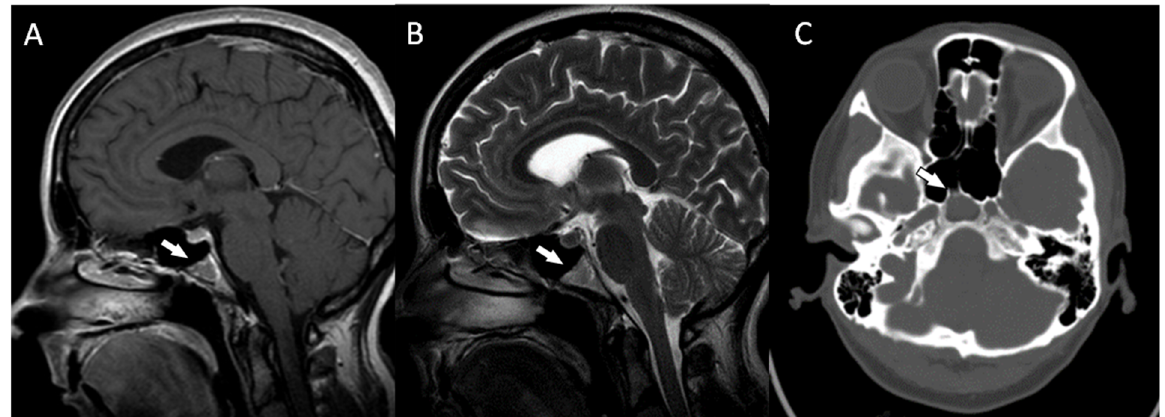
Figure 2. ( A ) The magnetic resonance postcontrast T1-weighted sagittal image, demonstrating the isointense lesion with hyperintense borders (arrow). The image suggested chordoma or fibrous dysplasia ( B ). The magnetic resonance T2-weighted dark fluid sagittal image, showing the isointense clival lesion (arrow) ( C ). The computed tomography image, showing the centrally located lesion with a hypersclerotic rim (arrow). The tumor did not infiltrate the sphenoid sinuses. Endoscopic transnasal transsphenoidal surgery was performed, with the complete resection of the lesion. An intraoperative macroscopic image of the tumor showed a well-